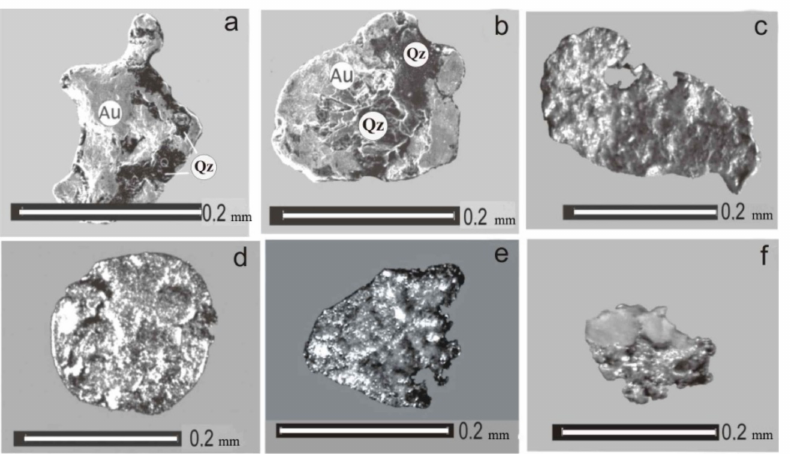
Figure 16. Pseudo-ore gold from deposits of different ages in the east of the Siberian Platform: ( a , b ) pseudo-intergrowths of gold (Au) with quartz (Qz), Lena–Anabar interfluve; ( c , d ) flake gold particles with casts of pressing-in on the surface of the minerals of the host deposits of the middle Lena basin; ( e , f ) flakes with ragged edges and depressed quartz on the surface of the Lena–Viluy interfluves. Identified morphological features of native gold allowed us to refer to pseudo-ore